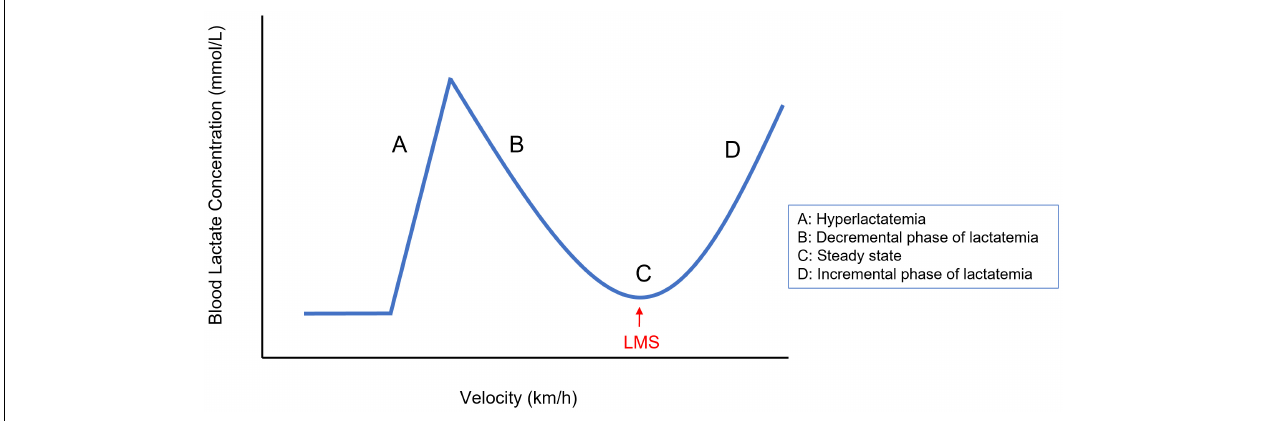
FIGURE 2 | Typical shape of the LMS curve illustrating the consecutive phases (A–D) of the LMS protocol. The LMS is marked by an arrowhead. LMS, lactate minimum